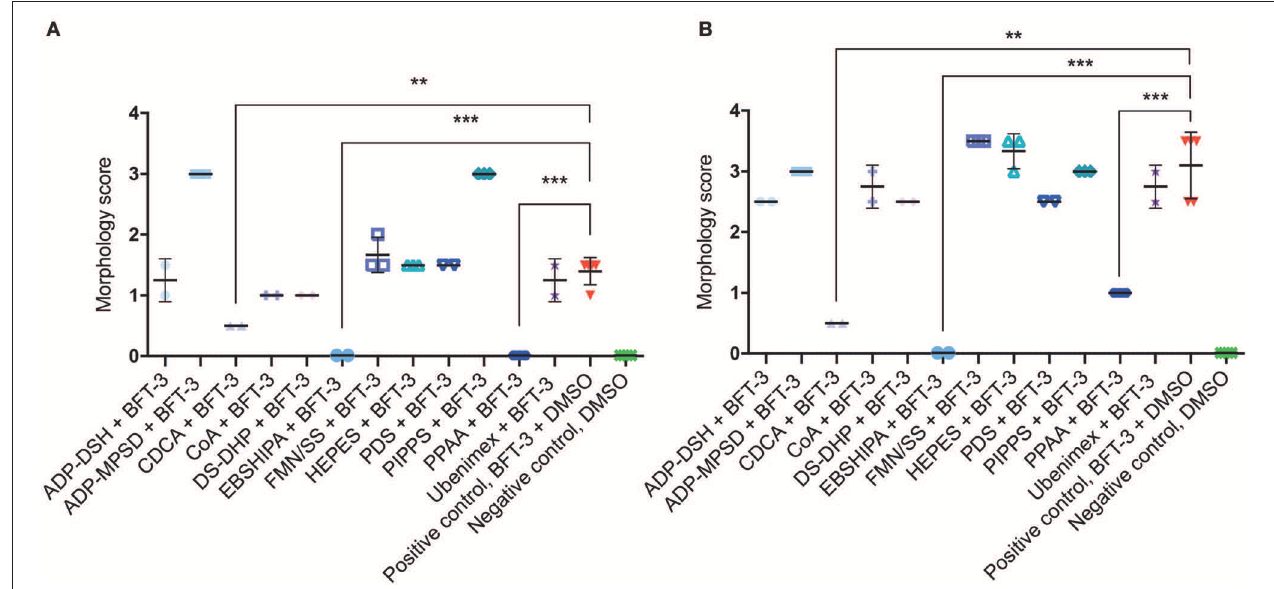
FIGURE 3 | Morphological changes of in silico selected compounds. Drugs EBSHIPA, PPAA, and CDCA showed a 100%, 68–100%, and 64–84% reduction of BFT-3 related morphology changes, respectively, after 2 (A) and 3 (B) hours. N = 2–5 for each condition with (error) bars indicating means and standard deviations. (unpaired t -test, ** P < 0.01; *** P <